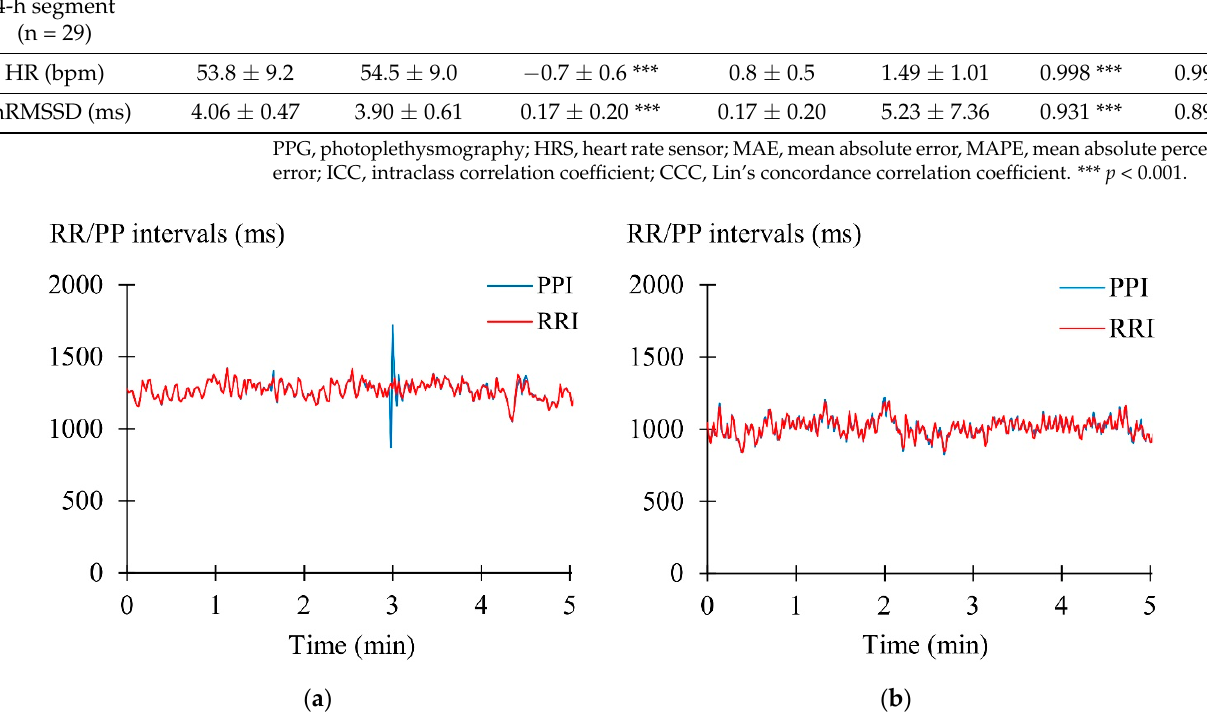
Figure 4. ( a ) Participant with a good agreement between the PP and RR intervals ( b ) Participant with an erroneous extra beat and missed